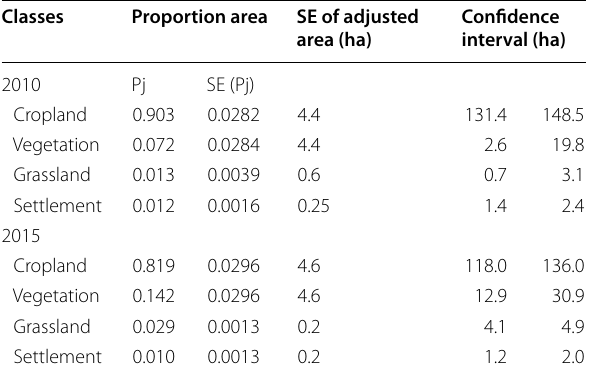
Table 4 Estimate and confidence interval in 2010 and